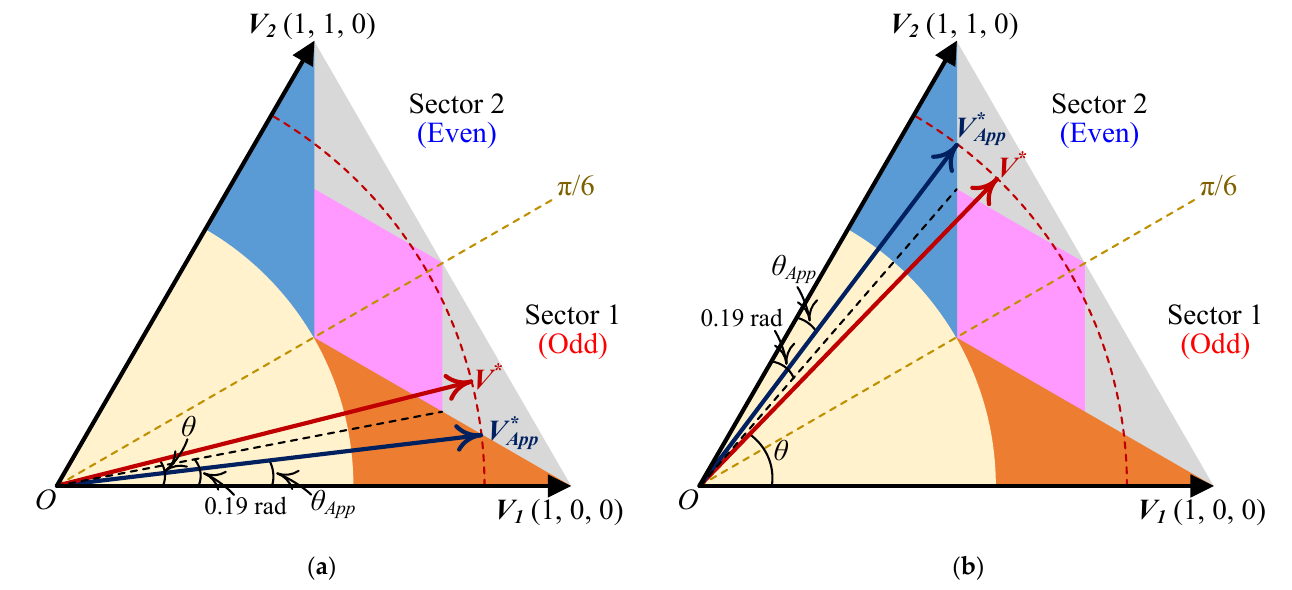
Figure 8. Approximate method for reference voltage vector in VA area: ( a ) Sector 1; ( b ) Sector 2. Sub-Sector 3: Vs. Area